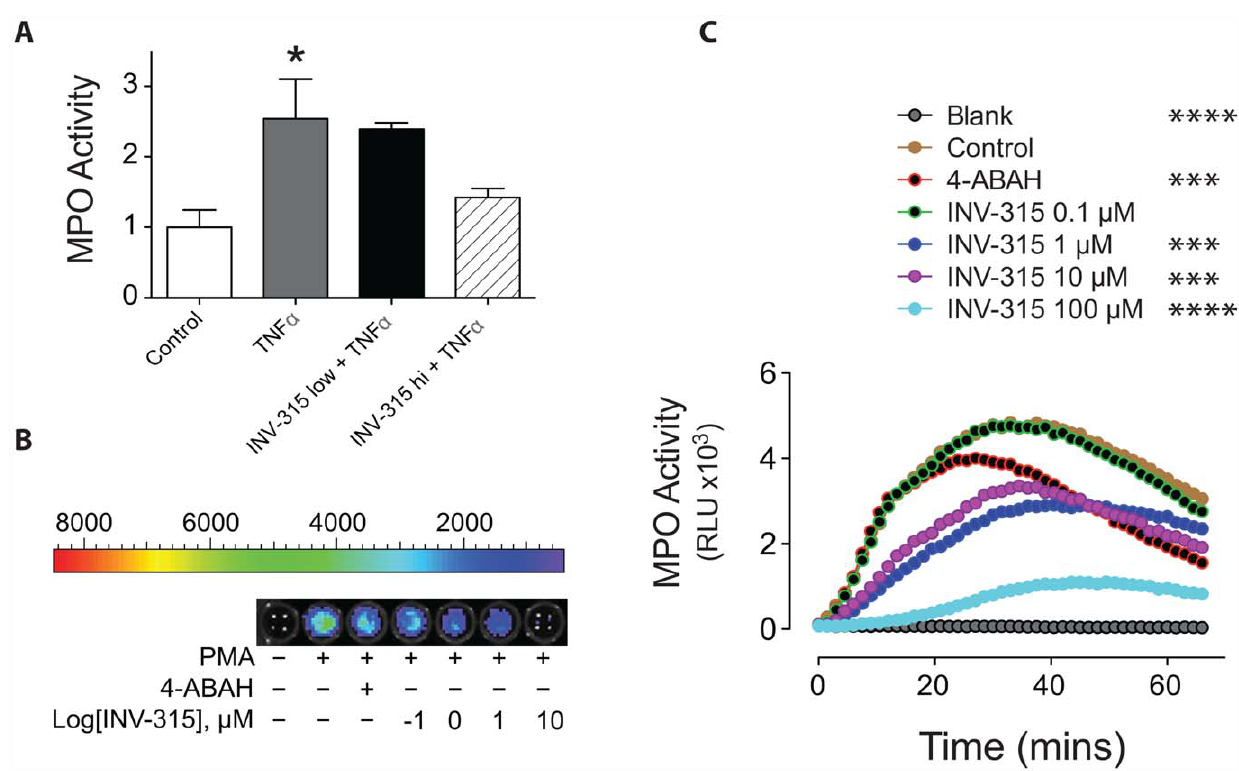
Figure 6. Effect of INV-315 on MPO activity in mice peritoneal macrophages and human blood. A. MPO activity in macrophages derived from the peritoneal cavity of C57BL/6 mice. Data were derived from 5–7 mice for each group. B. Luminol-bioluminescence imaging of PMA- stimulated blood. C. Luminol bioluminescence was plotted as a function of time and concentration of INV-315. Data were derived from triplicate results. * P , 0.05, ** P , 0.01, *** P , 0.001, **** P , 0.0001, compared with control group.